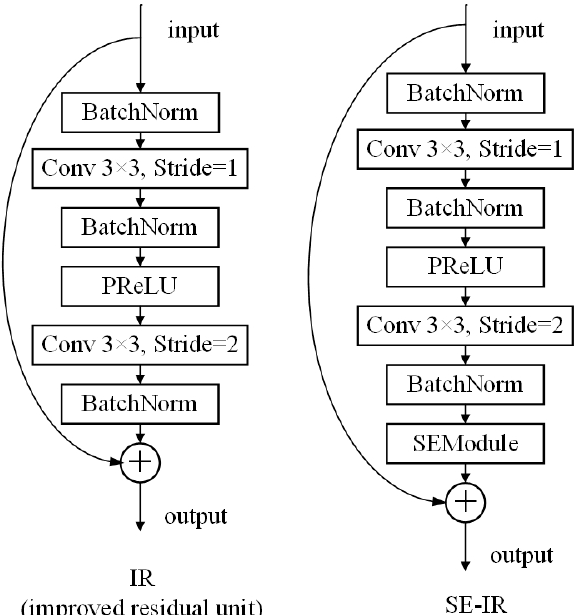
Figure 5. The structure of the IR unit and SE-IR block. The left IR unit means the improved residual unit, and the right SE-IR represents the improved residual unit combined with the SE block.